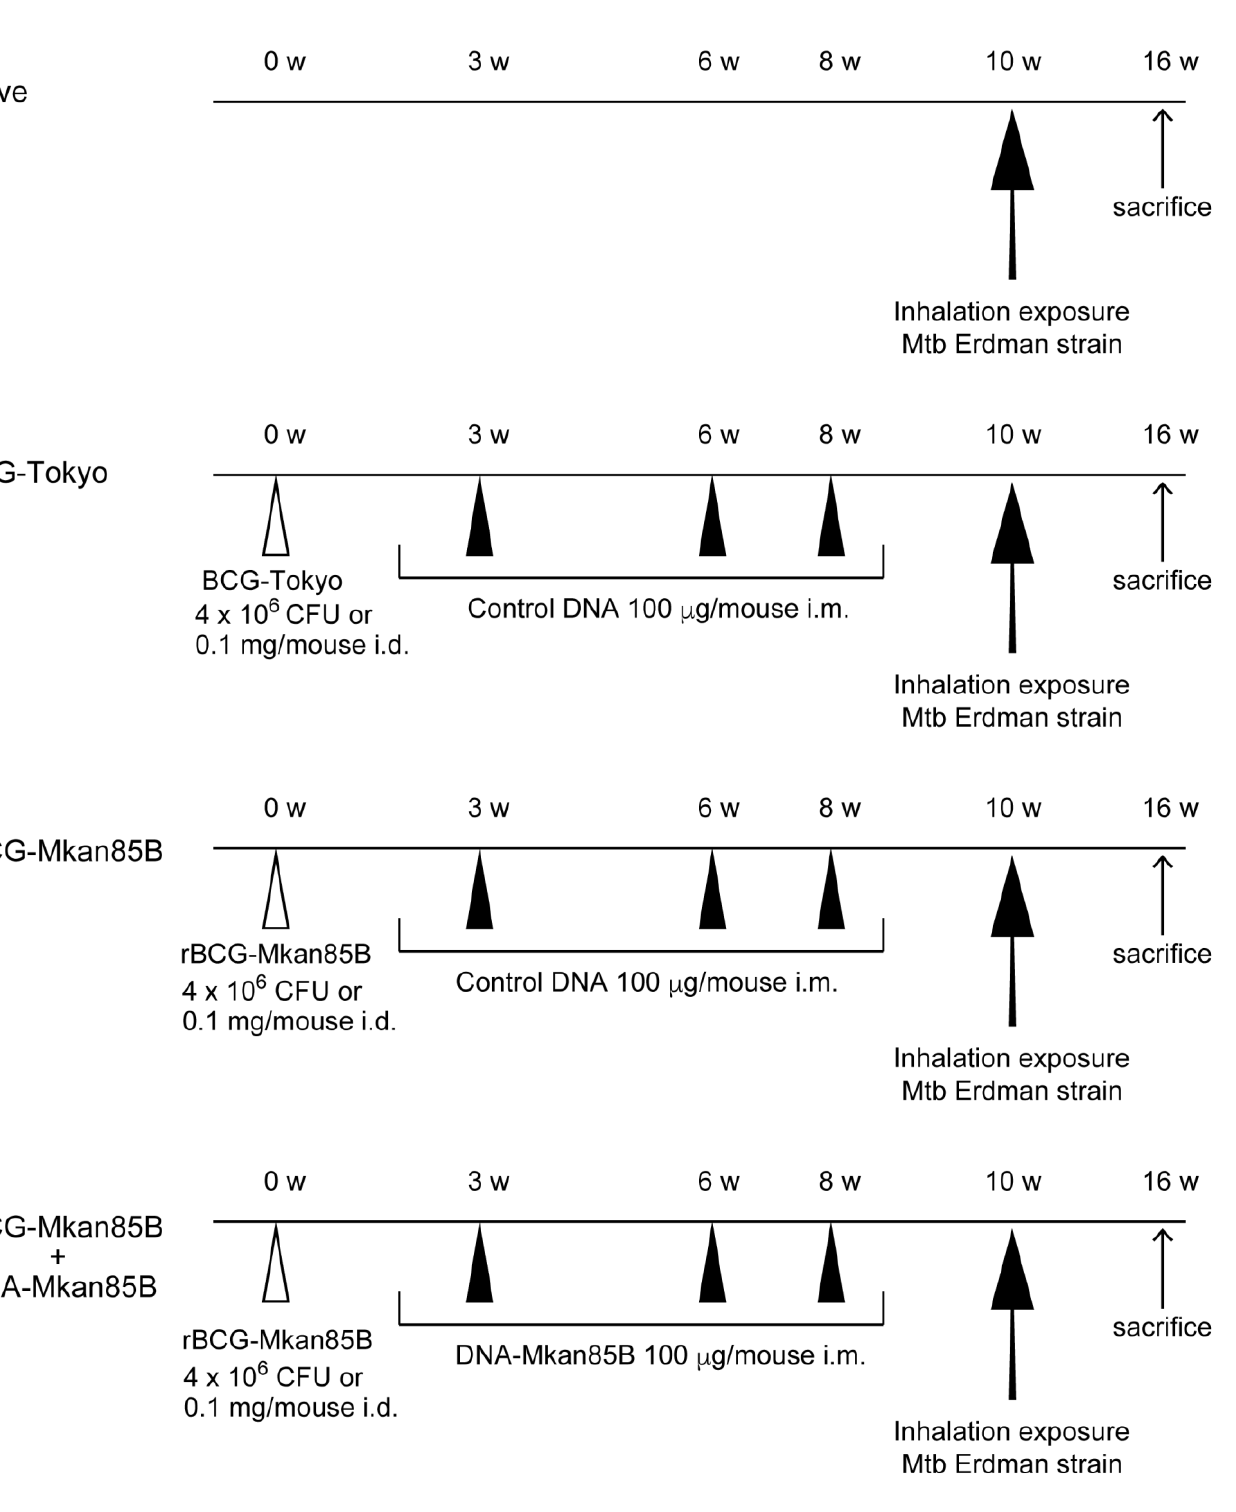
Figure 1. Immunization schedule. CB6F1 mice were immunized with either the BCG vaccine or the rBCG-Mkan85B vaccine at a concentration of 4 × 10 6 CFUs or 0.1 mg of bacilli i.d., and administered 100 μg of plasmid DNA or control DNA in saline i.m. three times. Six to ten mice were included in each group. The experiments were performed six times independently.